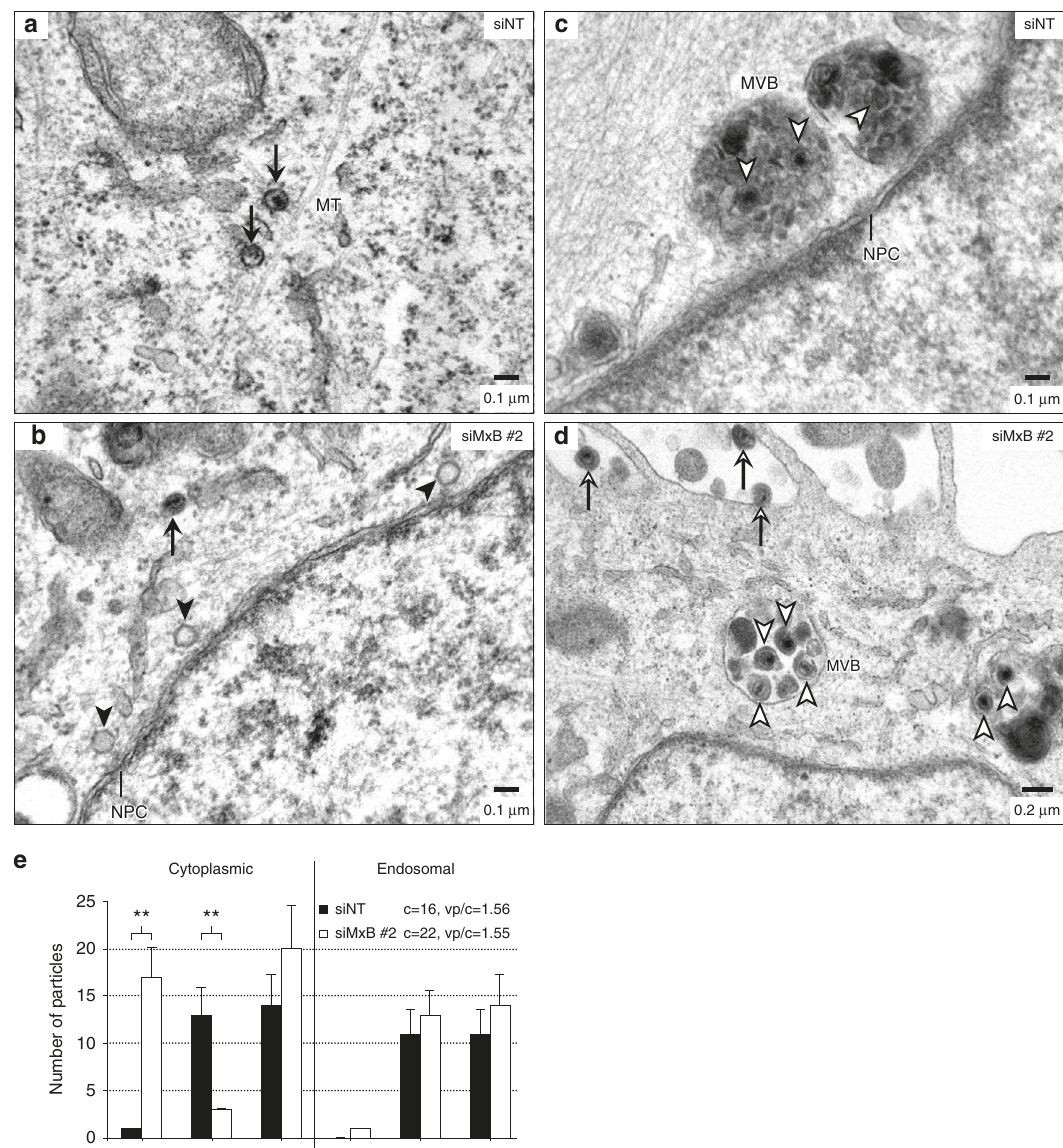
Fig. 6 MxB inhibits HSV-1 genome uncoating. a – d A549-MxB cells were transfected with the indicated siRNAs. At 60 h post transfection, cells were infected with HSV-1 strain MacIntyre (MOI = 500) in the presence of cycloheximide. Cells were fi xed 3 h post infection and subjected to TEM analysis. Black arrows: full capsids; black arrowheads: empty capsids; open arrows: extracellular virions at the plasma membrane; open arrowheads: virions in multivesicular bodies (MVB). MT, microtubule; NPC, nuclear pore complex. e Subcellular quanti fi cation of empty and full capsids in the cytoplasm and endosomal compartments depicting the mean number of virus particles (vp) in analysed cells (c) + s.e.m. as derived from unpaired two-tailed Student ’ s t tests. ** p < 0.01. vp/c, average number of virus particles analysed per